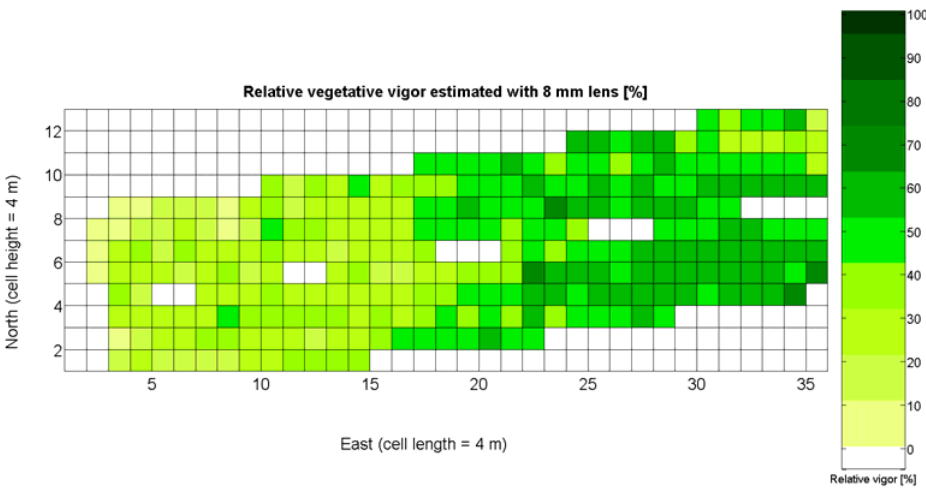
Figure 7. CB map of relative vine vigor estimated with an 8 mm lens: V-8